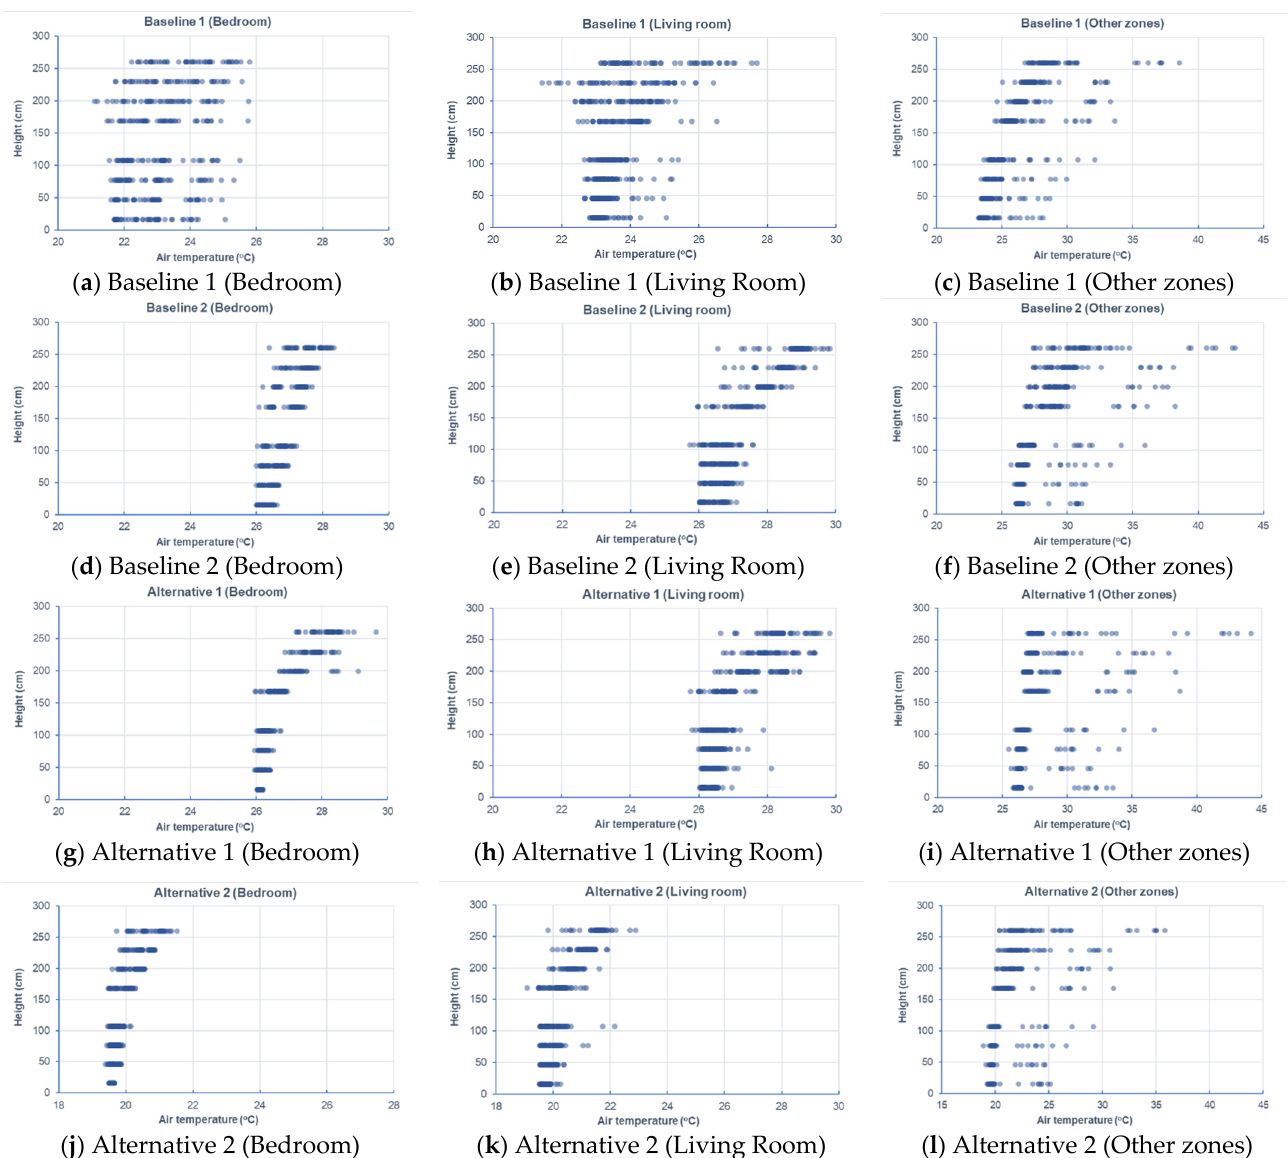
Figure 9. Air velocity for different rooms taken from different design options.